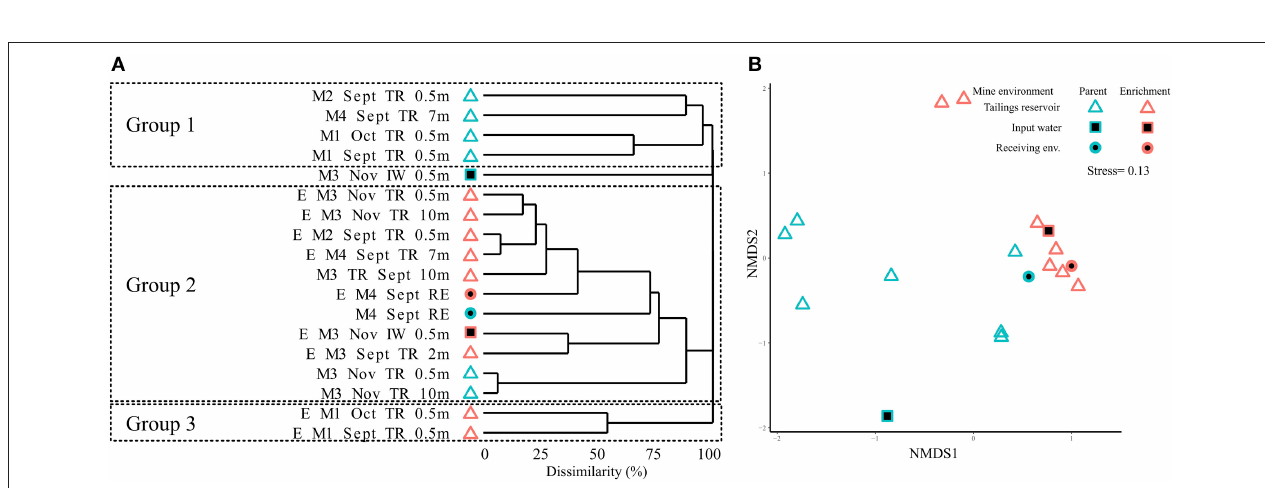
FIGURE 2 | Microbial community structure for different mine environments. (A) Bray-Curtis dissimilarity based hierarchical clustering of samples at sequence variants level (obtained by obtained by Illumina sequencing of 16S rRNA gene amplicons). M, mine; E, enrichment; TR, tailings reservoir; IW, input water; RE, receiving environment. Sampling depth is surface water unless depicted (m). (B) Non-metric multidimensional scaling (NMDS) plot of samples at sequence variants level (based on Bray-Curtis dissimilarity from Illumina sequencing of 16S rRNA gene amplicons), depicting different mine environments and differences between microbial community structure of enrichments and mines (ANOSIM; R = 0.42; P < 0.001).